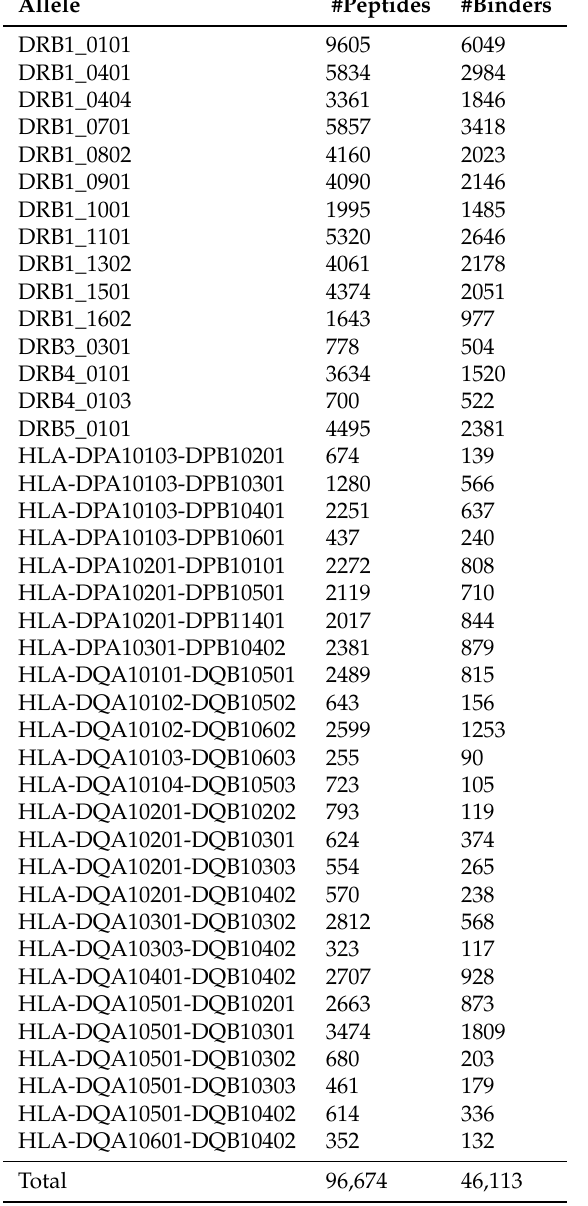
Table 1. Overview of the class II MHC peptide-binding